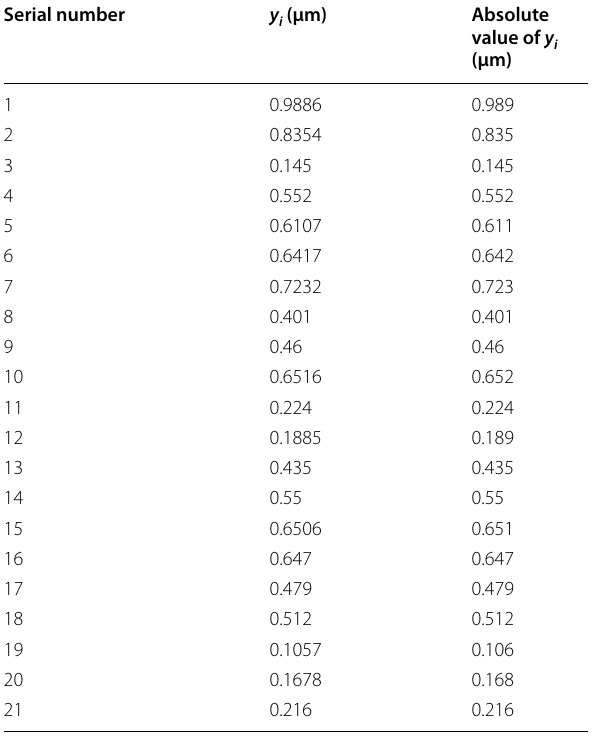
Table 2 Extraction data of surface roughness